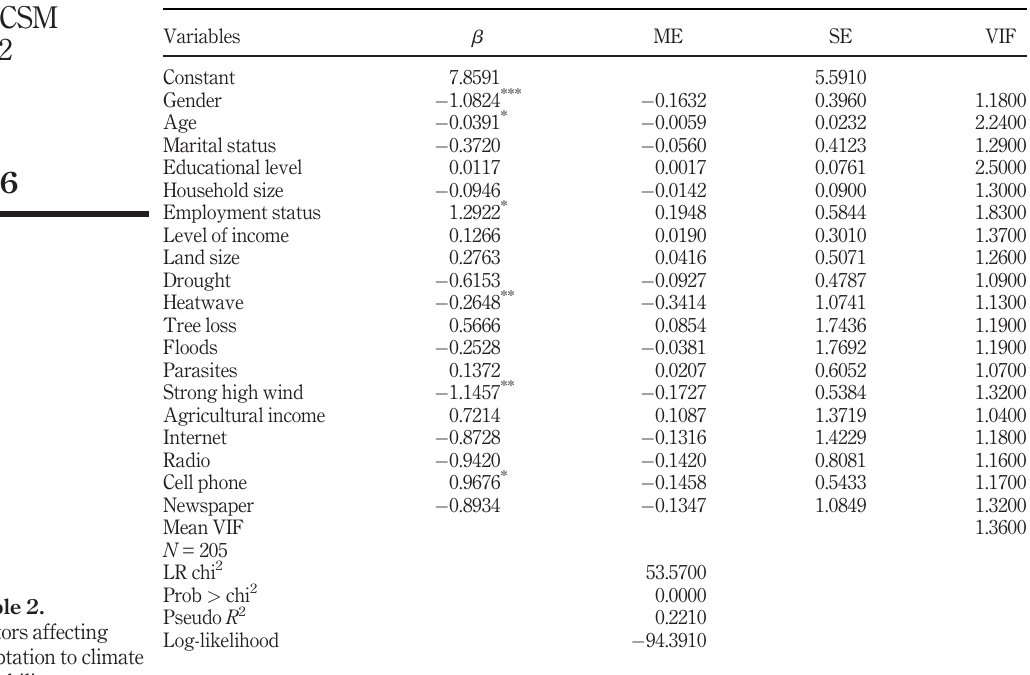
Table 2. Factors affecting adaptation to climate